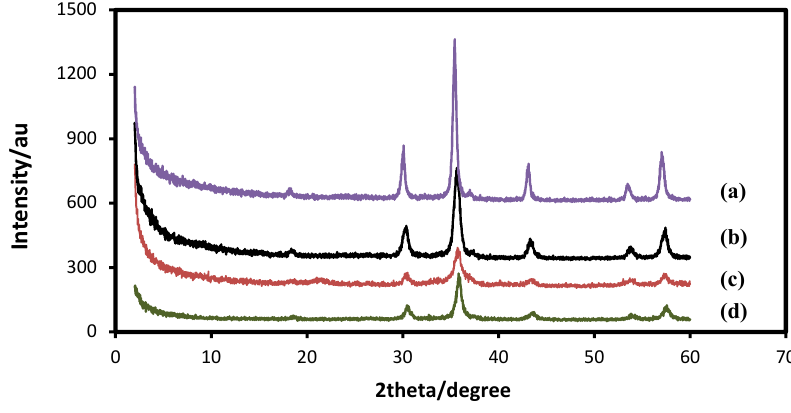
O MNPs at different initial 3 4